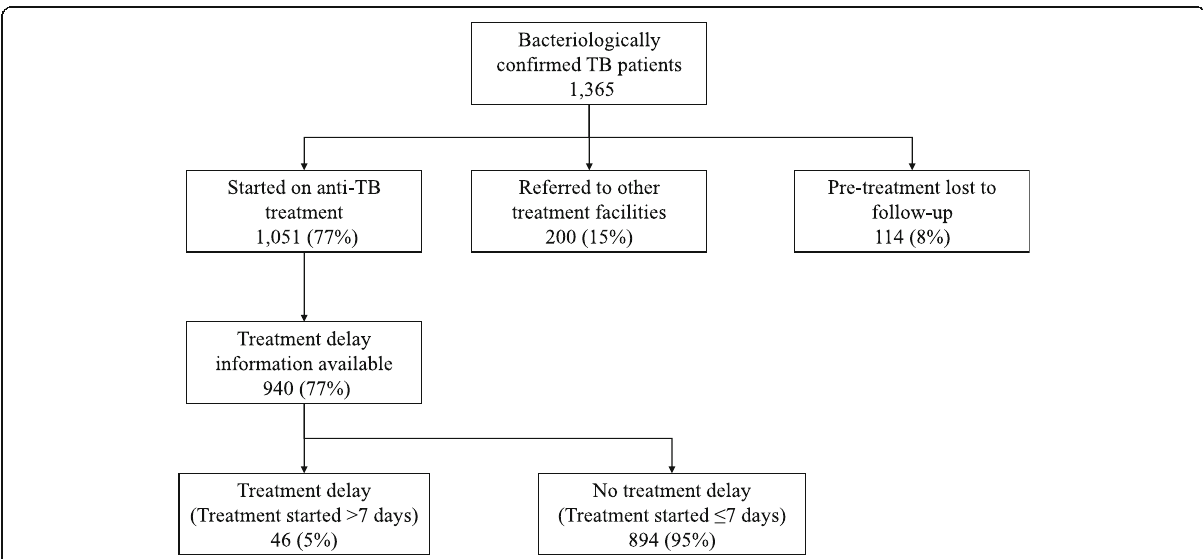
Fig. 2 Flow chart of bacteriologically confirmed TB patients diagnosed in 21 township health centres of Mandalay Region of Myanmar between January and June 2017. TB,